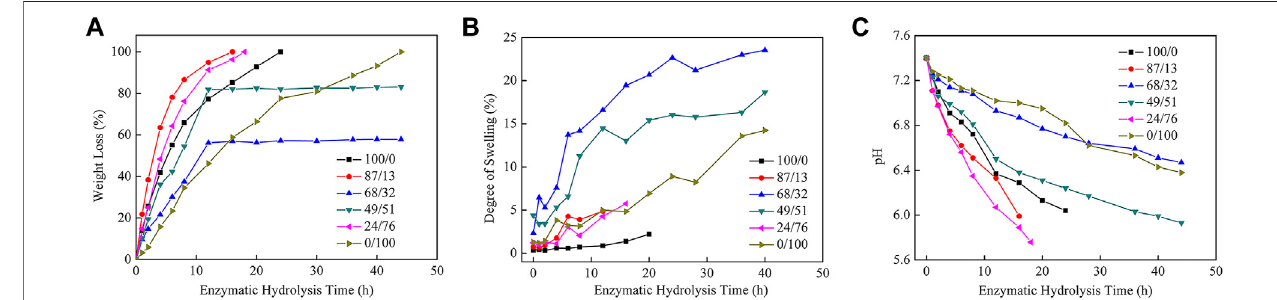
FIGURE 5 | FT-IR spectra measured of the polyesters at different extents of enzymatic hydrolysis. (A – F) : PHS, P(HS-co-13ES), P(HS-co-32ES), P(HS-co-51ES), P(HS-co-76ES), and PES.